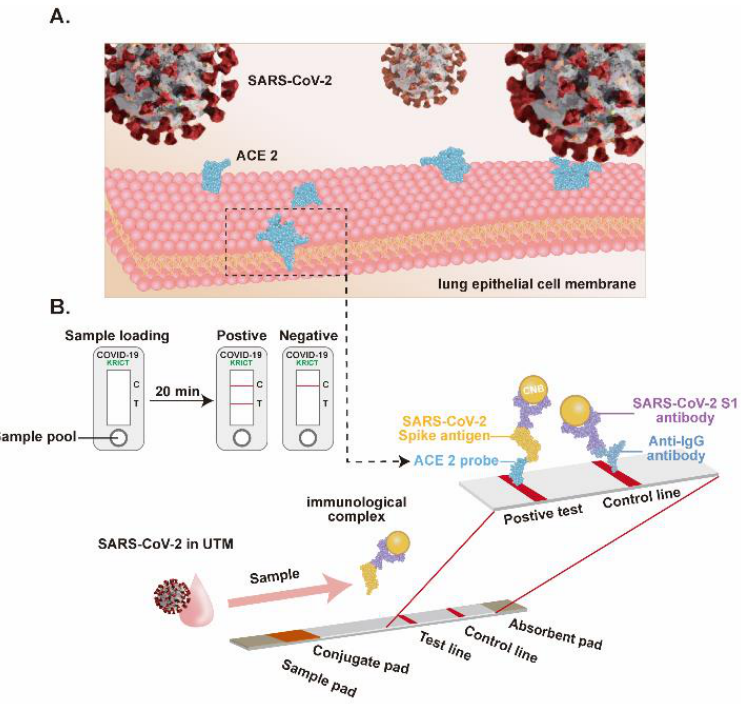
Figure 9. Lateral flow assay-based SARS-CoV-2 detection. ( A ), The cellular receptor of the SARS-CoV-2, the ACE2 expressed on lung epithelial cells. ( B ), Schematic of the LFIA for SARS-CoV-2 detection. Adapted from Ref. [53] with permission from Elsevier. © 2020 Published by Elsevier B.V.